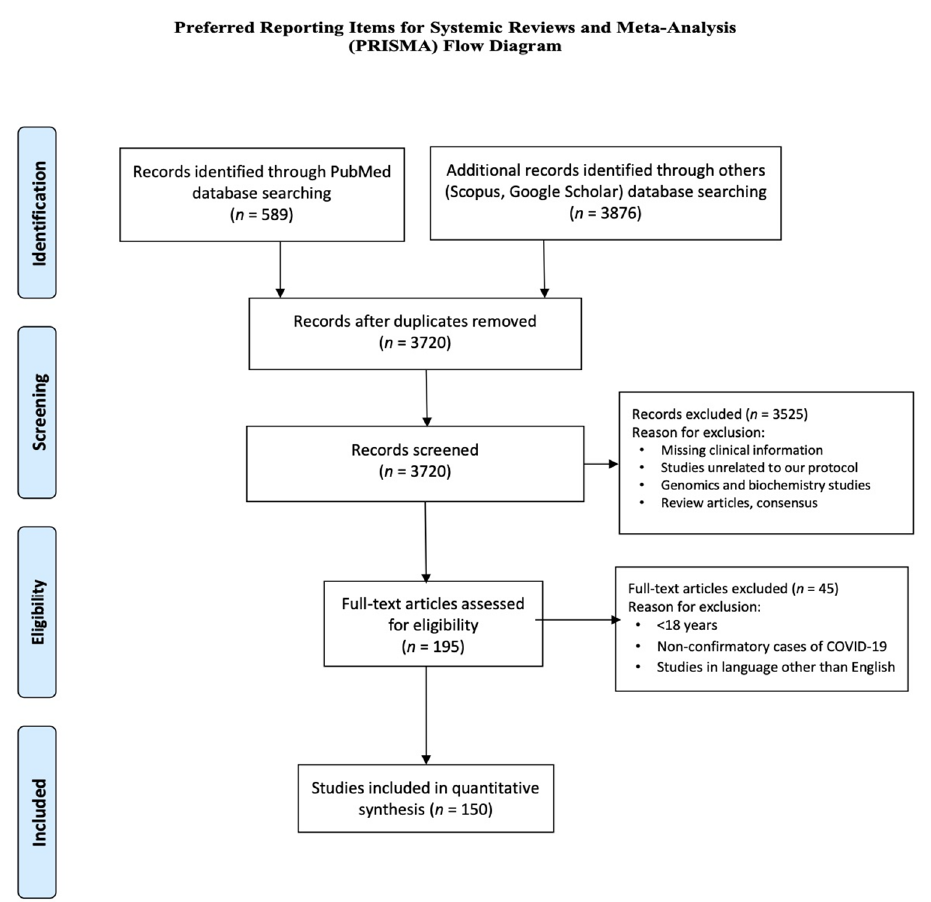
Figure 1. PRISMA flow diagram of systematic review. The flow diagram depicts the flow of information through the different phases of the systematic review. It maps out the number of records identified, included and excluded, and the reasons for exclusions.